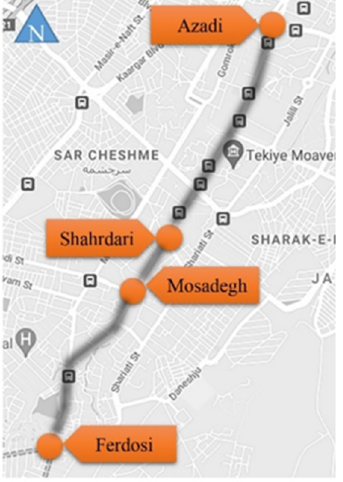
Figure 2. The location of four public open spaces on the map.